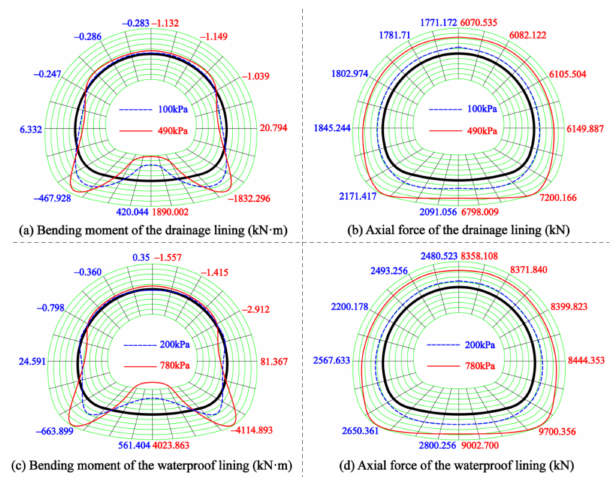
Figure 9. Distributions of the internal forces in the general stress state and ultimate failure state. The curves of the internal forces at key points of the drainage and waterproof lining with changes in the water pressure for the entire test are presented in Figure 10. As shown, the positive bending moment of the inverted arch and the negative bending moment of the bottom of the wall increased linearly, with an increase in the water pressure in a certain range (drainage lining: water pressure of <0.3 MPa; waterproof lining: water pressure of <0.6 MPa), and then exhibited the change characteristic of nonlinear failure. Among the parts of the tunnel lining, the absolute values of the positive and negative bending moments were the largest for the inverted arch and the bottom of the wall, respectively. The bending moments of the other parts were essentially unchanged, with small absolute values and minimal differences. The axial force increased linearly with an increase in the water pressure in a certain range (drainage lining: water pressure of <0.4 MPa; waterproof lining: water pressure of <0.6 MPa) and exhibited little difference among different parts. Thus, the bottom of the wall and the inverted arch were the two weakest parts of the lining structure under the action of water pressure.